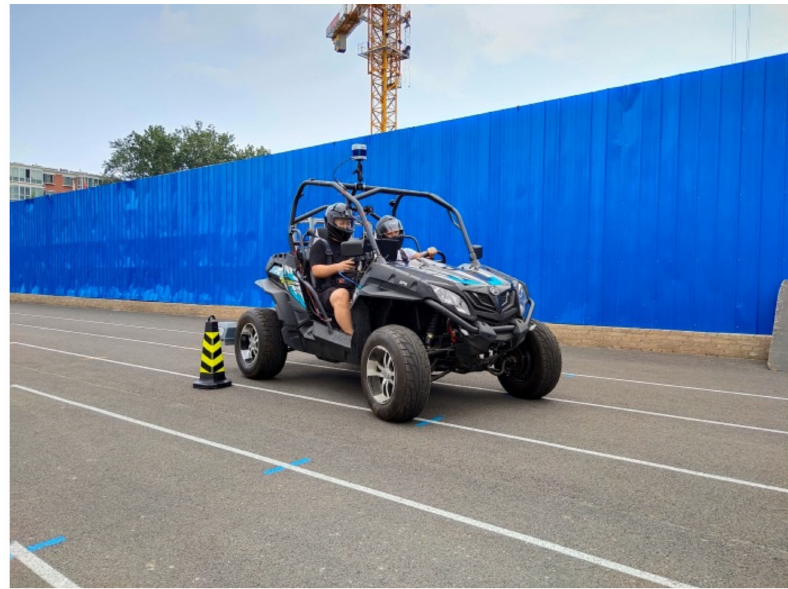
Figure 8. Real vehicle test